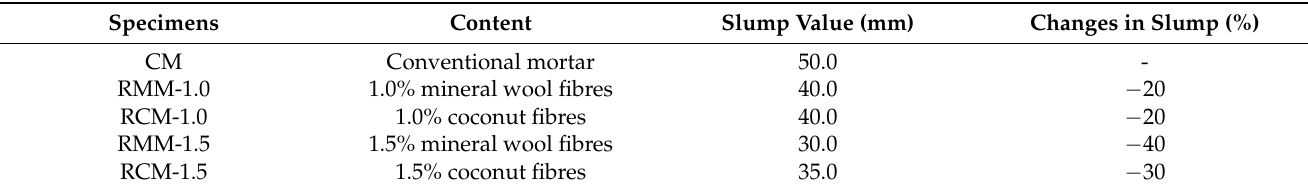
Table 3. Slump test